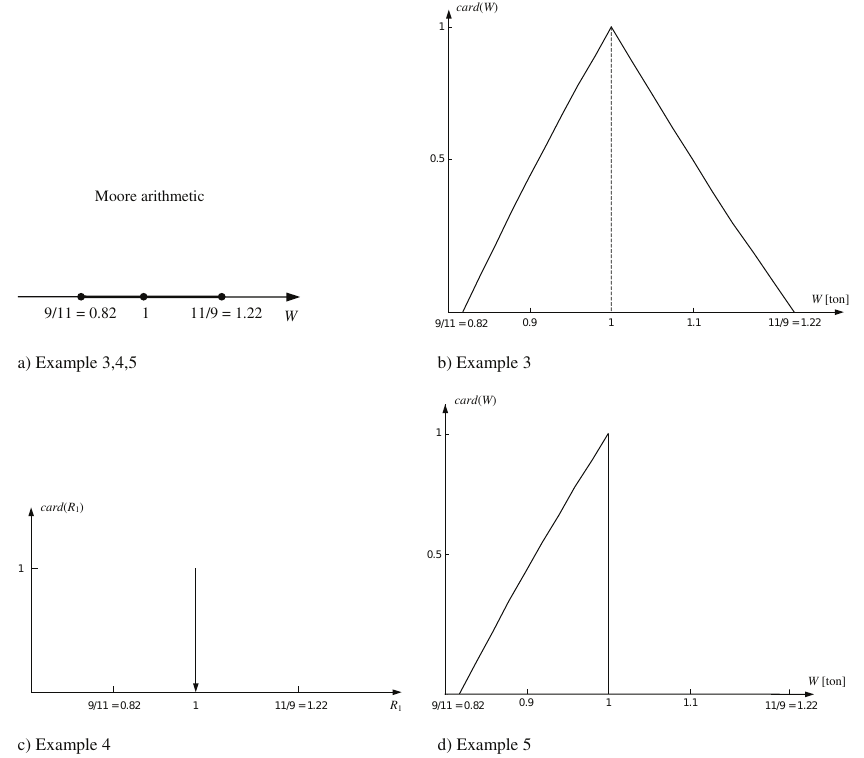
Fig. 16. Solution representations of the division of ‘identical’ IPVs from Examples 3, 4 and 5 with the Moore arithmetic (a) and with the RDM-arithmetic (b,c,d) expressed as cardinality